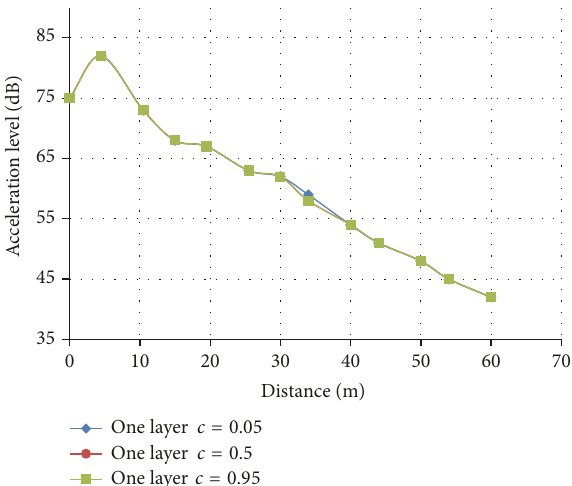
Figure 16: The comparison of acceleration among cases 1 , 4 , and 5 in Scheme 2 .